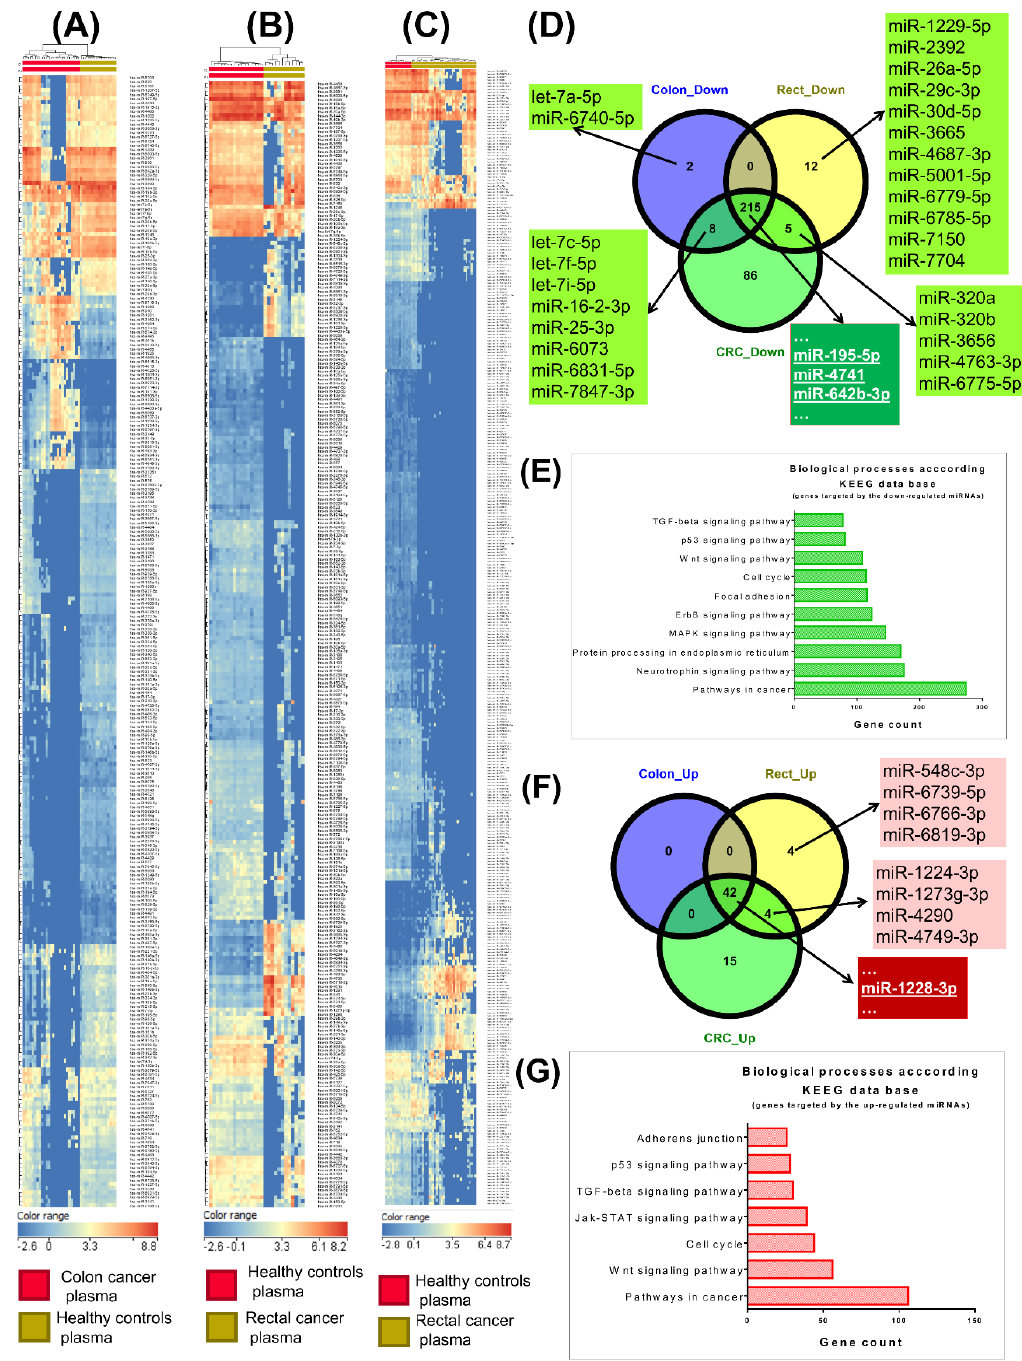
Figure 1. Summary of common miRNAs which are differentially expressed in plasma samples in colon, rectal, and colorectal cancer, respectively, versus healthy controls, displayed as heatmap and Venn diagrams. ( A – C ) Heatmap of miRNA microarray expression data for ( A ) colon, ( B ) rectal, ( C ) colorectal cancer versus healthy subjects. ( D ) The common miRNAs are presented by overlapping downregulated miRNAs in the three analyzed groups. ( E ) Biological processes affected, identification of target genes for the downregulated miRNAs using miRnet connected with KEEG database. (F ) The common miRNAs are presented by overlapping overexpressed miRNAs in the three analyzed groups. ( G ) Biological processes affected, identification of target genes for the upregulated miRNAs using miRnet connected with KEEG database.